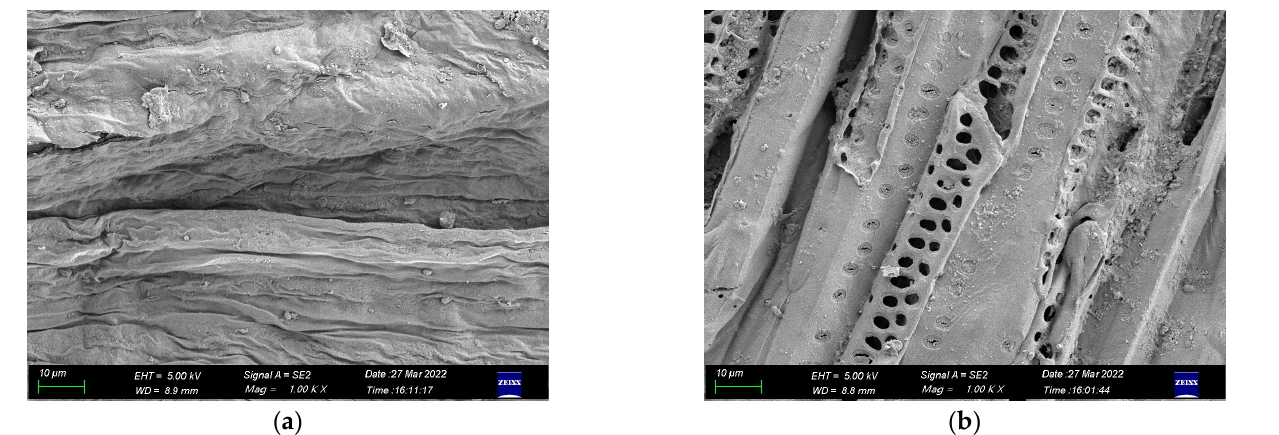
Figure 2. The dispersion of treated YDF and untreated YDF in water.